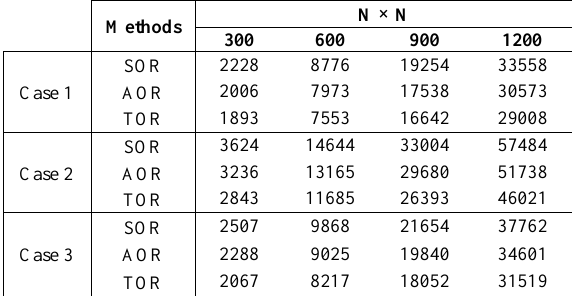
Table 1. Performance of the proposed methods in terms of iteration count.